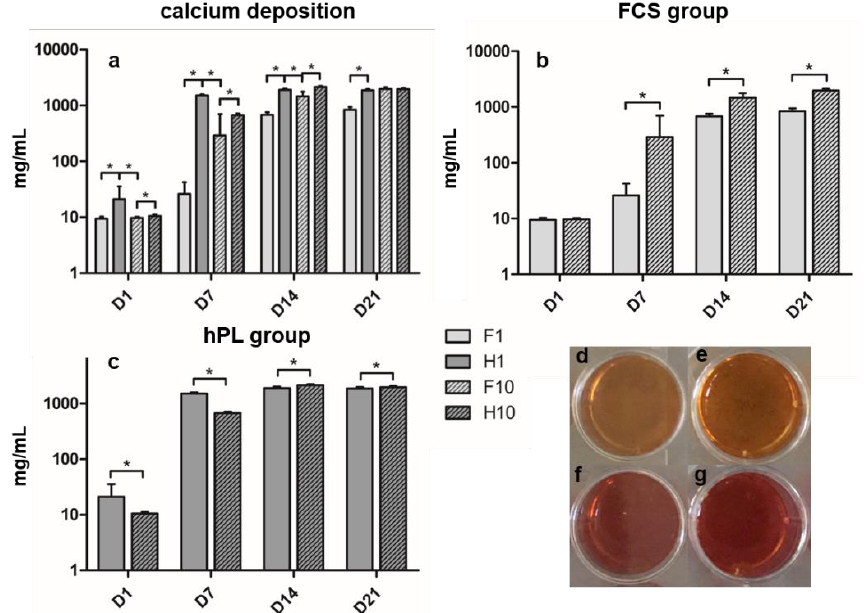
Figure 3. ( a ) Calcium content after alizarin red staining during time of incubation in ODM in mg / mL of all groups. ( b ) Calcium content of FCS groups. ( c ) Calcium content of hPL groups. ( d – g ) Cell layer in 24-well plate after alizarin red staining on D7. ( d ) F1. ( e ) F10. ( f ) H1. ( g ) H10. Values are shown as means with SD. * mark significant differences.